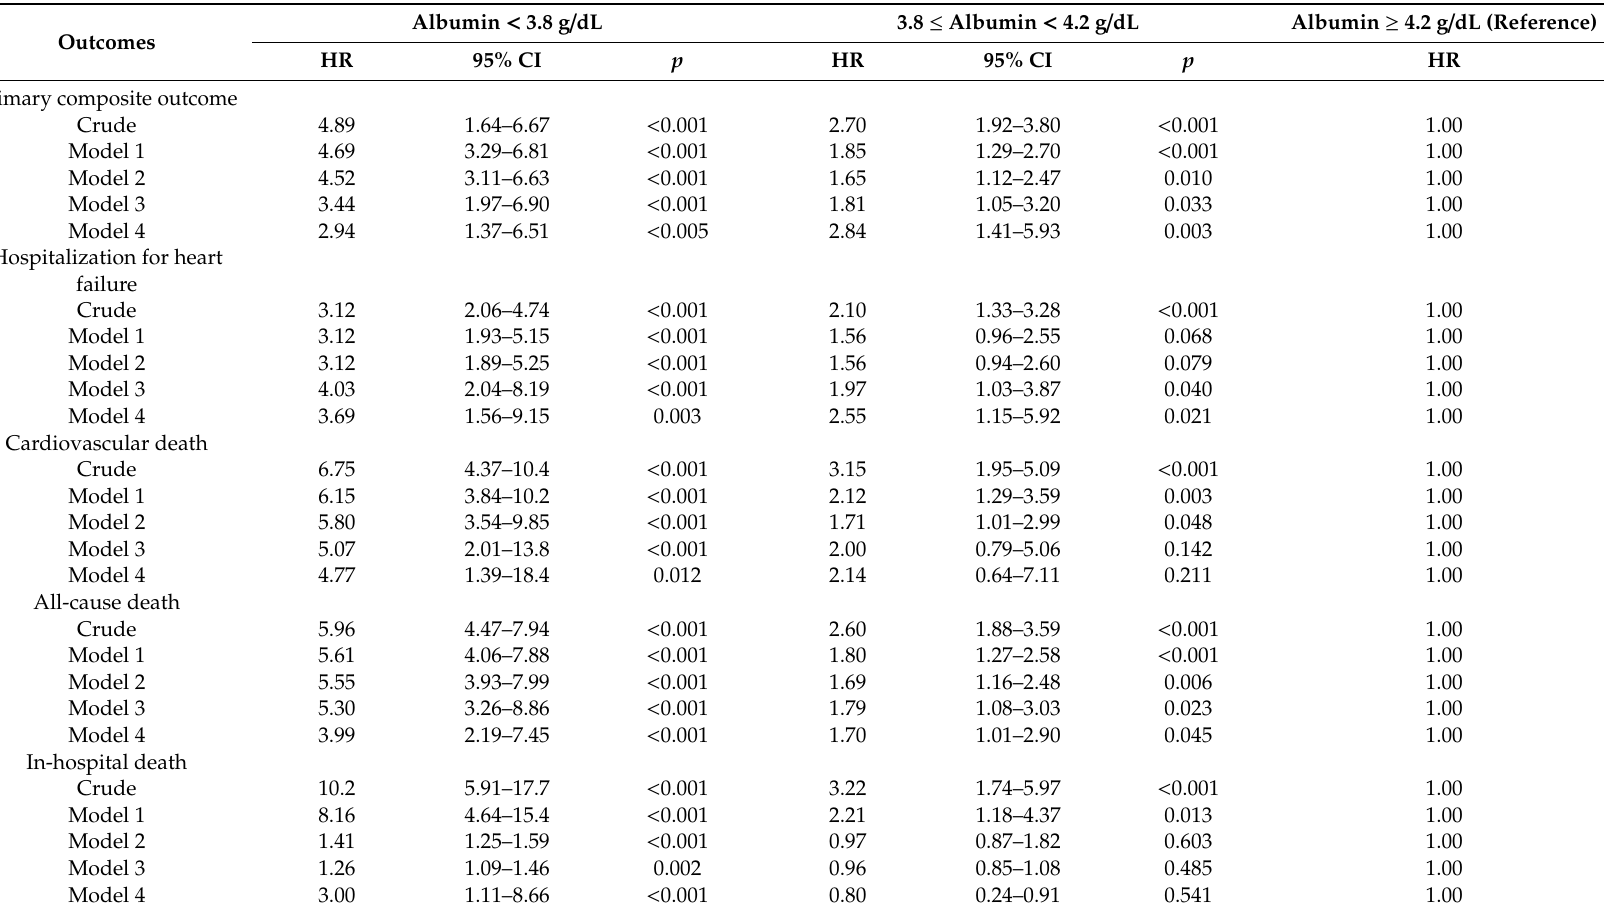
Table 2. Cox proportional hazards analysis for primary and secondary